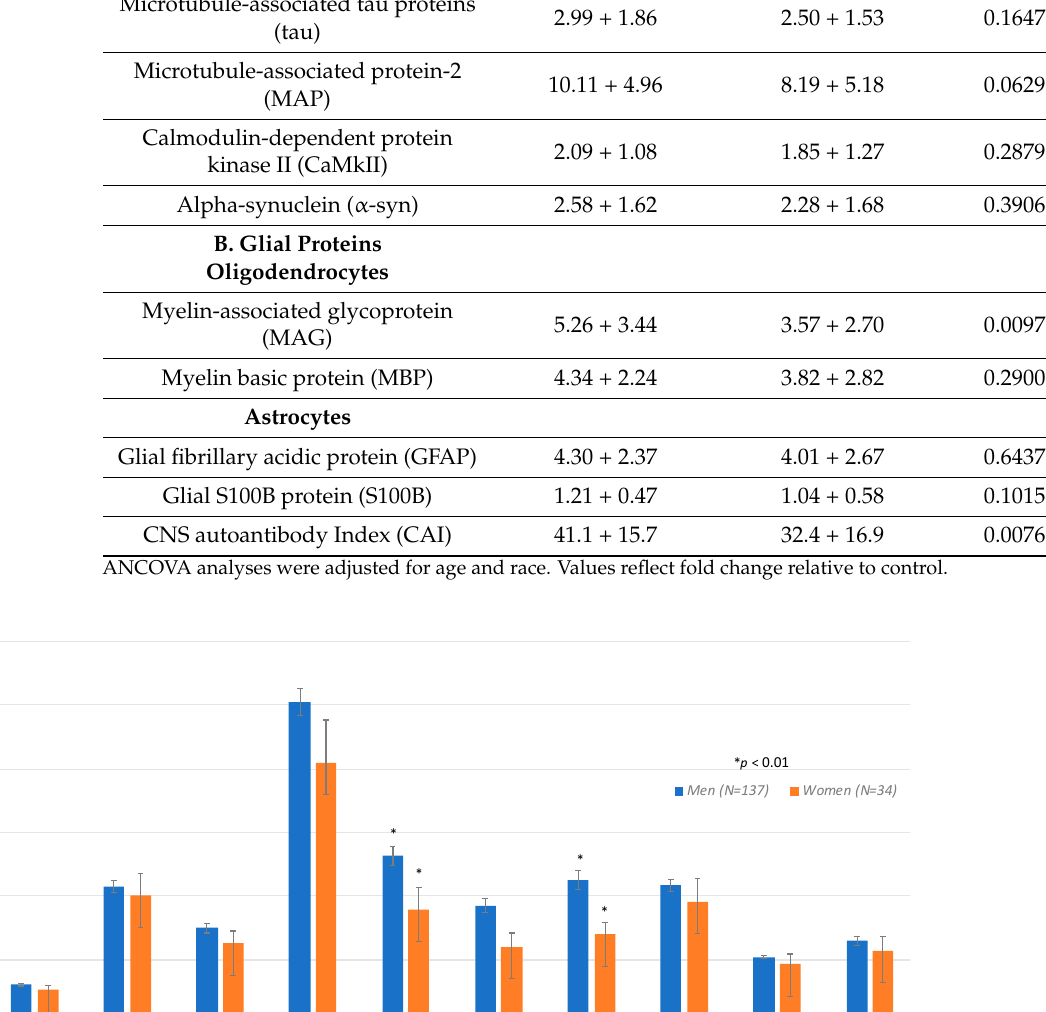
Table 2. Autoantibody ANCOVA analysis comparing men and women with Gulf War illness (GWI).